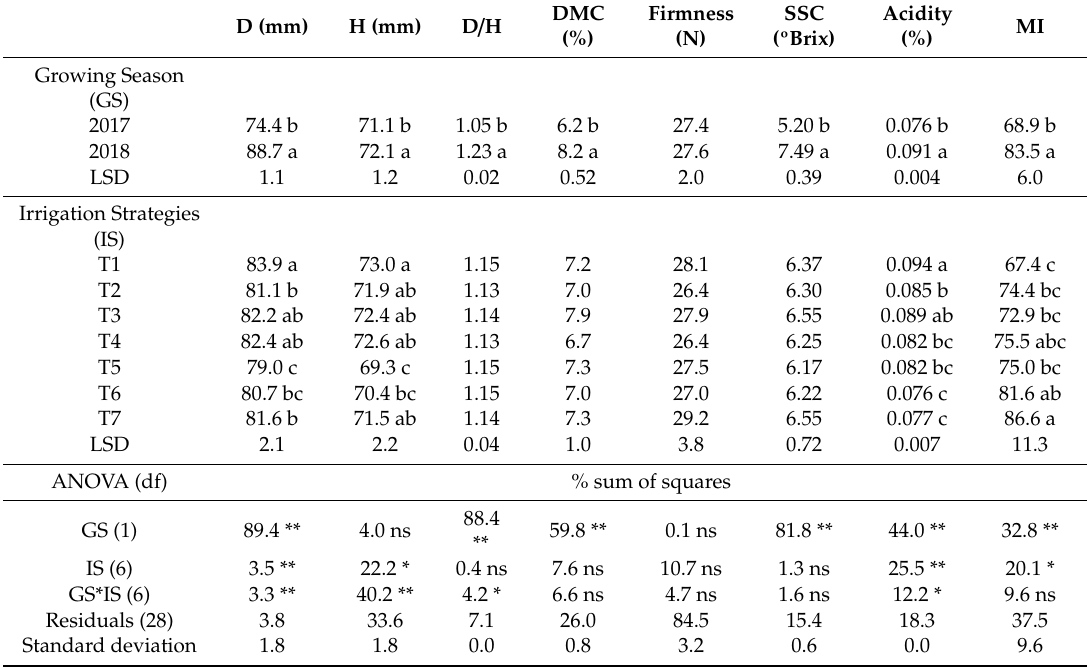
Table 6. E ff ects of the growing season and the irrigation strategy on bulb characteristics: size (diameter (D) and height (H), shape (D / H)); dry matter content (DMC); firmness; soluble solid content (SSC); acidity; and maturity index (MI).